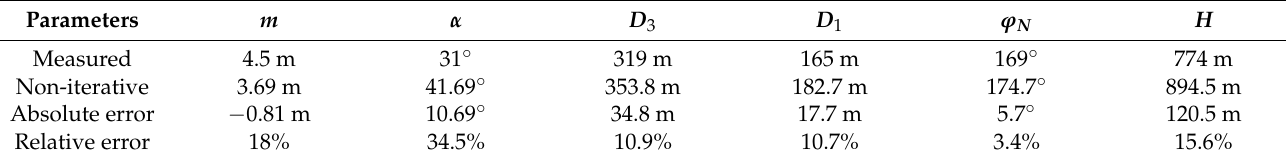
Table 4. Comparisons between the inverted and non-iterative geometric parameters of the 132610 working face. Parameters